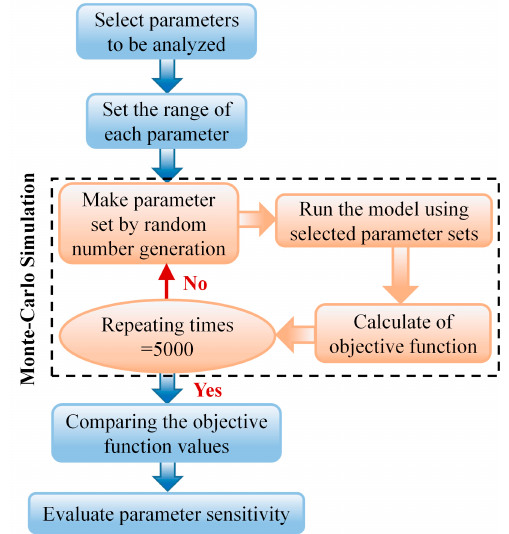
Figure 6. Flow chart of Global Multi-parametric Sensitivity Analysis (GMSA).